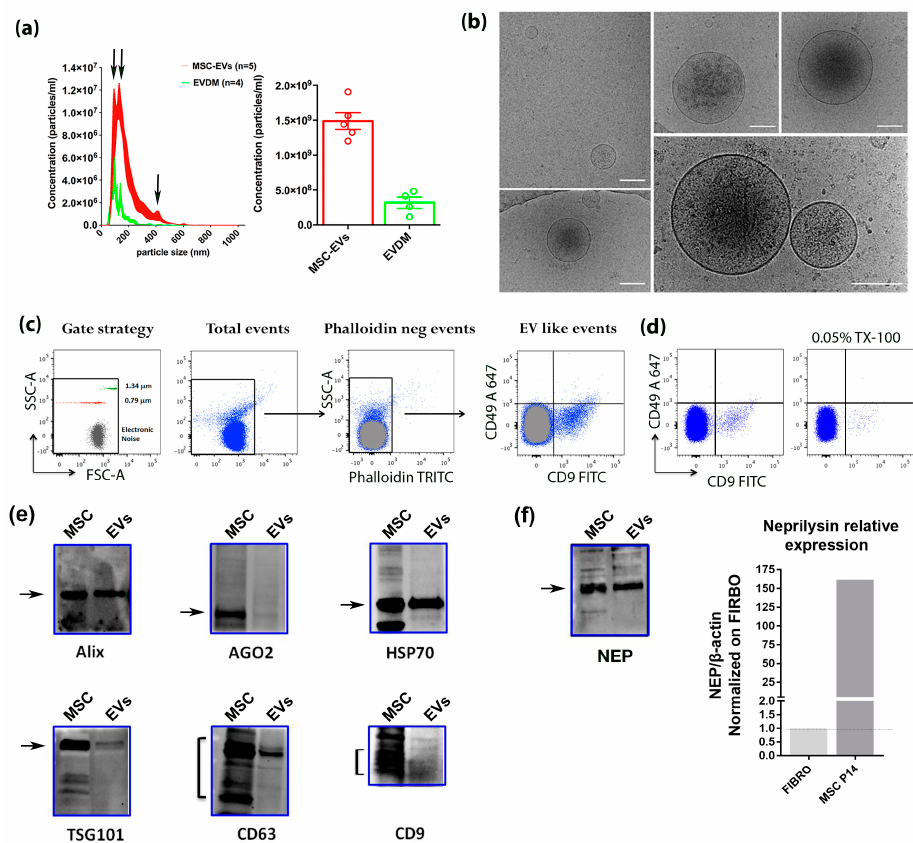
Figure 2. Characterization of BM-MSC-derived EVs. ( a ) Left panel: Nanoparticle Tracking Analysis (NanoSight NS300) of BM-MSC-EVs isolated by ultracentrifugation (red) compared to EV-depleted medium (EVDM) (green). Particle size distribution (left panel) shows that three populations corresponding to ~100 nm, ~150 nm, ~400 nm are the most represented on the red plot (arrows), indicating isolation of different pools of vesicles (> 100 nm exosomes and microvesicles). The green plot shows that fewer and smaller-sized vesicles (average size = 94.50 nm) remain in the medium after ultracentrifugation. Right panel: total particle concentration of isolated BM-MSC-EVs (red histogram) compared to the EVDM (green histogram). All data represent means and standard error of the mean (SEM) of 5 (BM-MSC-EV) and 4 (EVDM) independent preparations. ( b ) Visualization of purified BM-MSC-EVs by cryo-EM: a heterogeneous population of EVs surrounded by a lipid bilayer of sizes compatible with exosomes and microvesicles with an electron-dense core was observed. Note the integrity of membrane vesicles. Scale bar = 150 nm. ( c ) Representative panels showing flow cytometry analysis of EVs from BM-MSCs. Arrows between panels indicate the consecutive gating strategies for the analysis. The “gate strategy” panel shows the forward (FSC-A) and side (SSC-A) scatter density profile of 0.79 µ m (red dots) and 1.34 µ m (green dots) dimensional beads, which were used to include all events ( < 1.34 µ m) for specific marker analysis. Smaller events defined as “Electronic Noise”, falling below the limit of resolution of the instrument were also included in the “Total events” gate. BM-MSC-EVs appear in the “Total events” panel. Events falling within the “Electronic Noise”, represented in gray, were subtracted from all analysis gates. Bona fide EVs were Phalloidin negative (“Phalloidin neg events”) and were shown to be mainly CD9-FITC + , CD49-A647 + or double positive (“EV-like events”). ( d ) Adding 0.05% ( w / v ) TX-100 for 30 min after acquisition (left panel) resulted in a major decrease in the CD49 + / CD9 + stained population (right panel). ( e ) EVs and BM-MSC lysates (5 µ g) were analyzed by immunoblotting with antibodies against EV proteins Alix, AGO2, HSP70, TSG101, CD63 and CD9. ( f ) Left panel: Immunoblotting showing the presence of Neprilysin on EVs and in BM-MSC lysates (5 µ g). Right panel: Real-time PCR analysis of Nep relative expression in P14 BM-MSC RNA normalized to β -actin and to the expression in murine primary